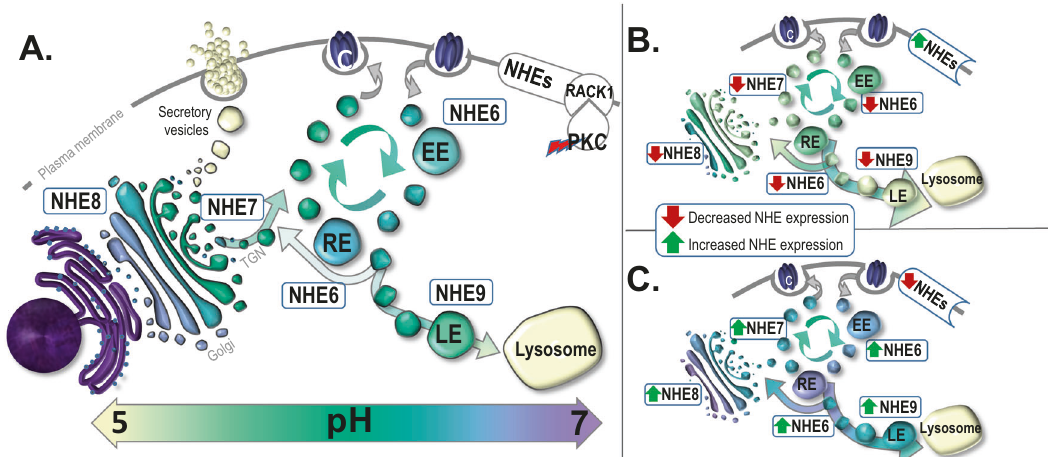
Fig. 1 Schematic representation of organellar Na + /H + exchanger (NHE) distributions and roles in intracellular compartmental pH regulation. A Organellar NHEs play an integral role in regulating the pH of the organelles involved in protein post-translational modi fi cation (PTM) and traf fi cking. NHE6 and NHE9 are localized to early/recycling and late endosomes, respectively while NHE7 and NHE8 are localized to trans-Golgi network and mid/trans-Golgi stacks, respectively. There is an interplay between NHEs at organelle targets and the plasma membrane (PM) with NHEs being stabilized at the PM by interactions with receptor of activated protein C kinase 1 (RACK1), which is activated by protein kinase C (PKC). Altered expression or distribution of organellar NHEs impacts organelle pH regulation and disrupts protein PTM and traf fi cking with ( B ) decreased expression or activity at organelle targets typically leading to acidi fi cation, and ( C ) increased expression or activity at organelle targets typically leading to alkalinization. EE early endosome, LE late endosome, RE recycling endosome, TGN trans-Golgi